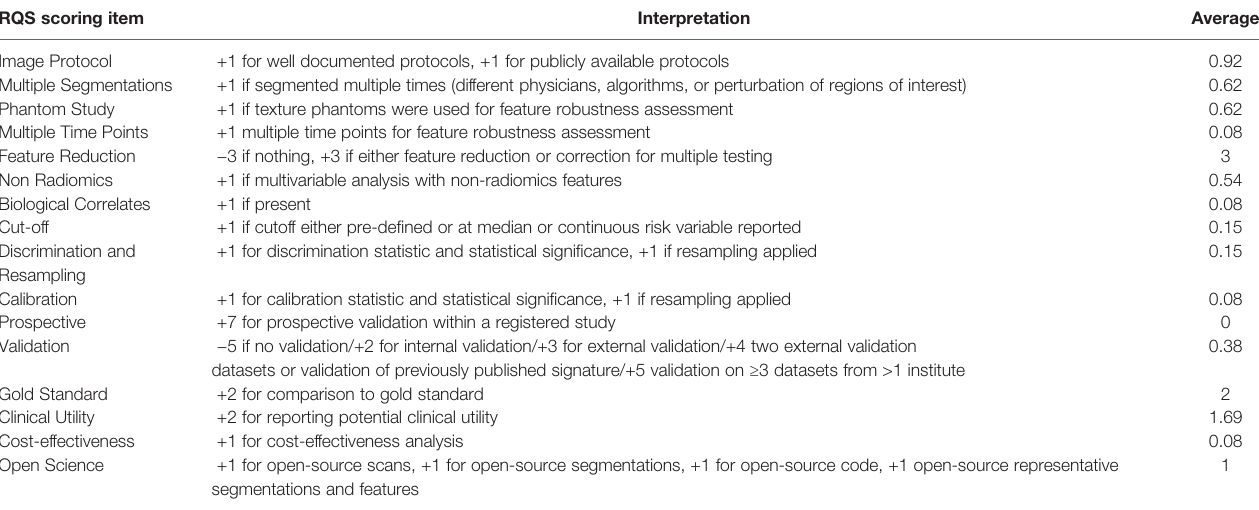
TABLE 1 | Elements of the RQS and average rating achieved by the studies included in this meta-analysis. RQS scoring